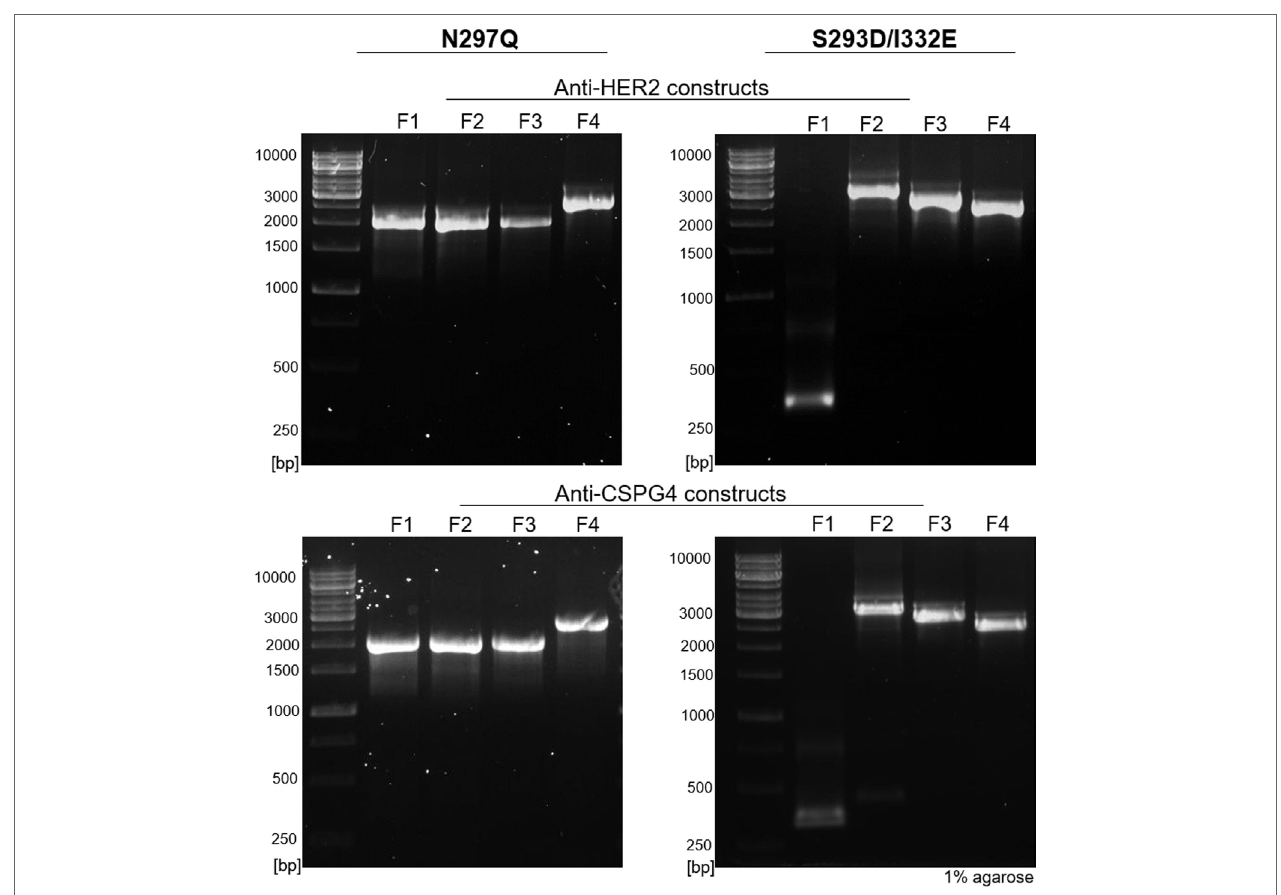
FigUre 2 | Agarose gel electrophoresis of polymerase incomplete primer extension (PIPE) PCR fragments for the generation of anti-HER2 and anti-CSPG4 N297Q (NQ) and S293D/I332E (DE) Fc mutant IgG1 antibodies. O’Generuler ™ 1 kb DNA ladder (Thermo Fischer Scientific) was used as a molecular weight marker. The lanes labeled F1–4 represent the NQ and DE PIPE PCR fragments 1–4, depicted in Figure 1 . The expected molecular weights (in bp) of each fragment are listed in Table 2